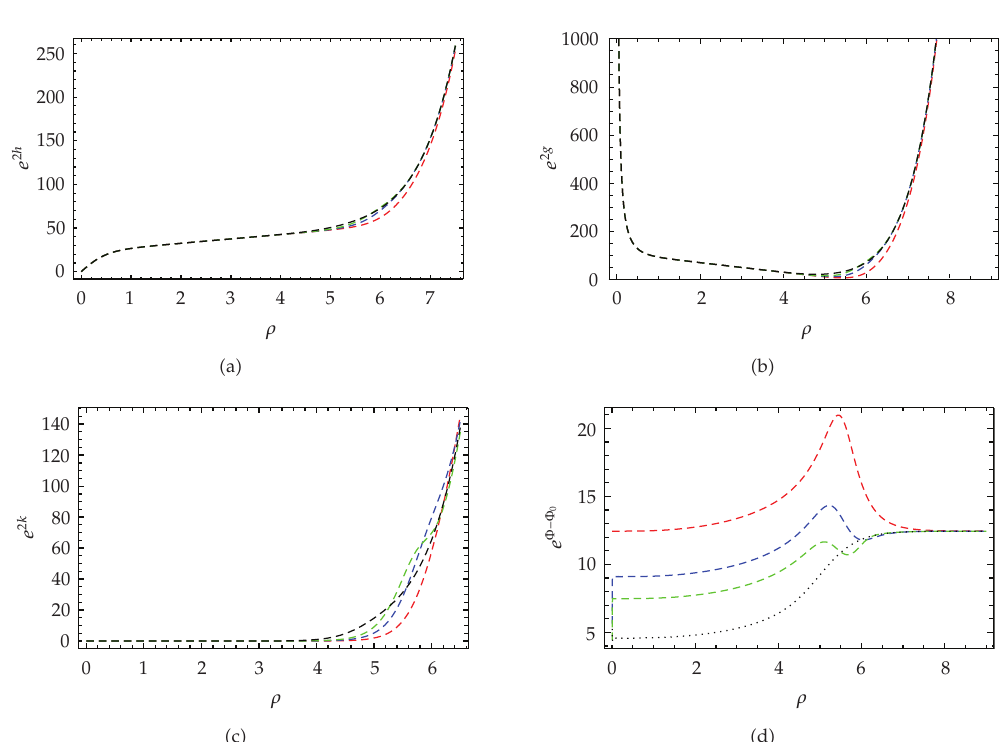
Figure 8: The background functions h , g , k , and Φ as a function of ρ , for the same parameters as in Figure 7, and with the same color-coding. It is clear that the expansion in (cid:5) 5.15 (cid:6) converges su ffi ciently fast for g and h , but some caution has to be used with Φ and k (cid:3) 56 (cid:4)